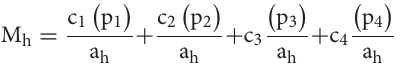
criteria to assign the conservation goals for each sub-habitat ( Supplementary Table 1 ) with the objective to prioritize